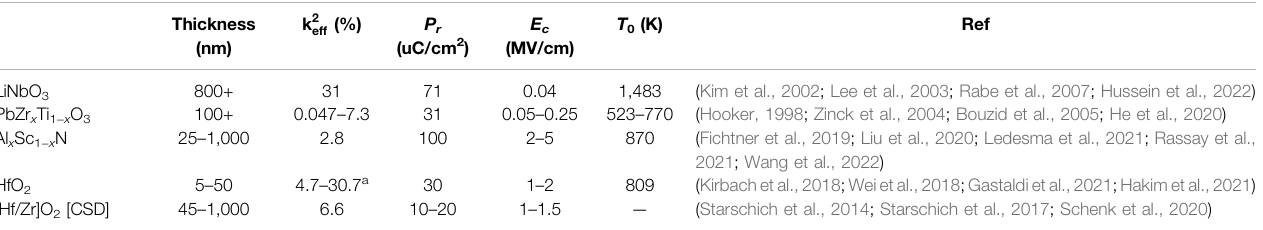
TABLE 3 | Potential value calculated given a stiffness of 320 GPa (Tharpe et al., 2021b), while permittivity and piezoelectric coef fi cients are taken from (Kirbach et al.,